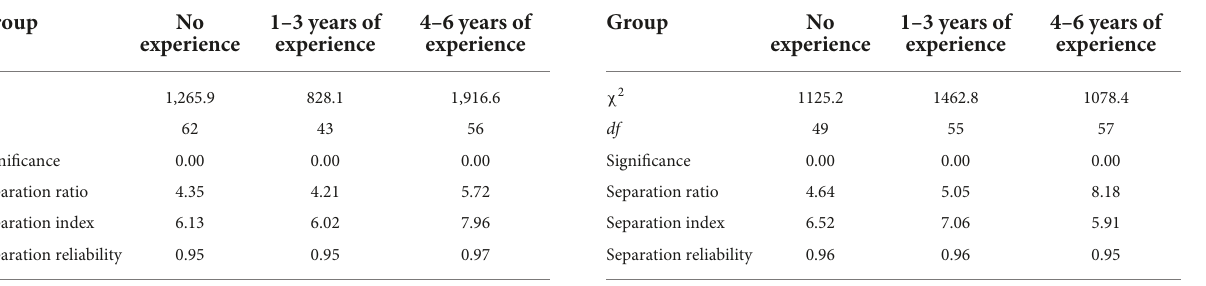
TABLE 7 Rater facet report based on rating experience.